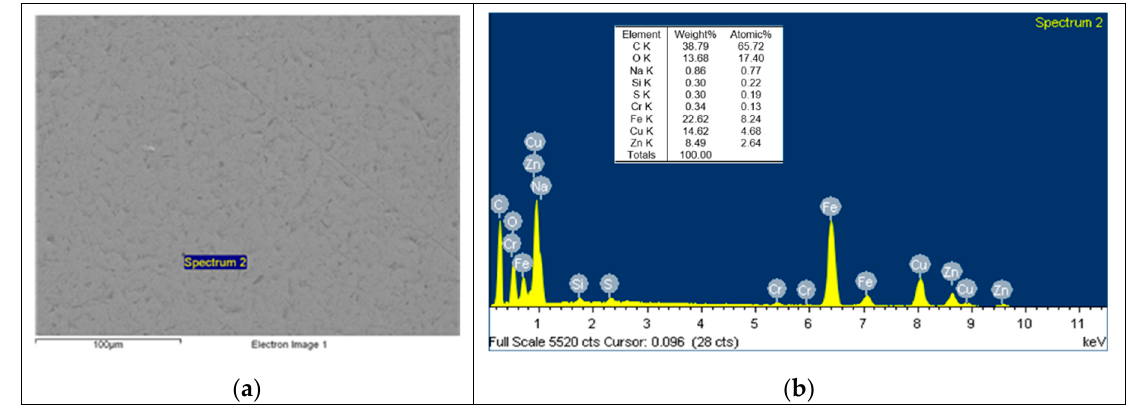
Figure 11. ( a ) SEM image and ( b ) EDS spectrum for discs tested against the PA46Z sample. Table 3. Summary of EDS spectra for PA46 samples.